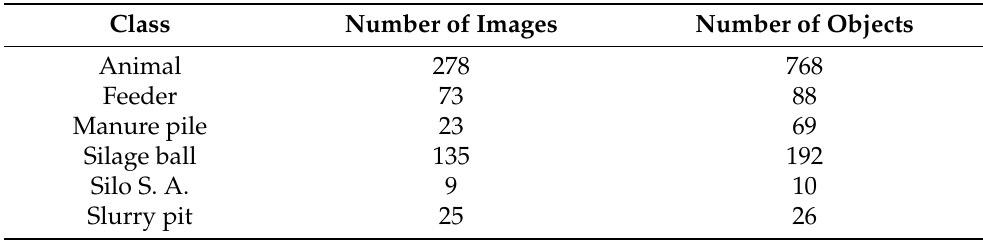
Figure 2. Example images of all classes taken from the proposed dataset. ( a , b ) animals; ( c , d ) feeders; ( e , f ) manure piles; ( g , h ) silage balls; ( i , j ) silage storage areas; ( k , l ) slurry pits. Table 2. Original number of images and instances per class after cropping original images to 416 ×